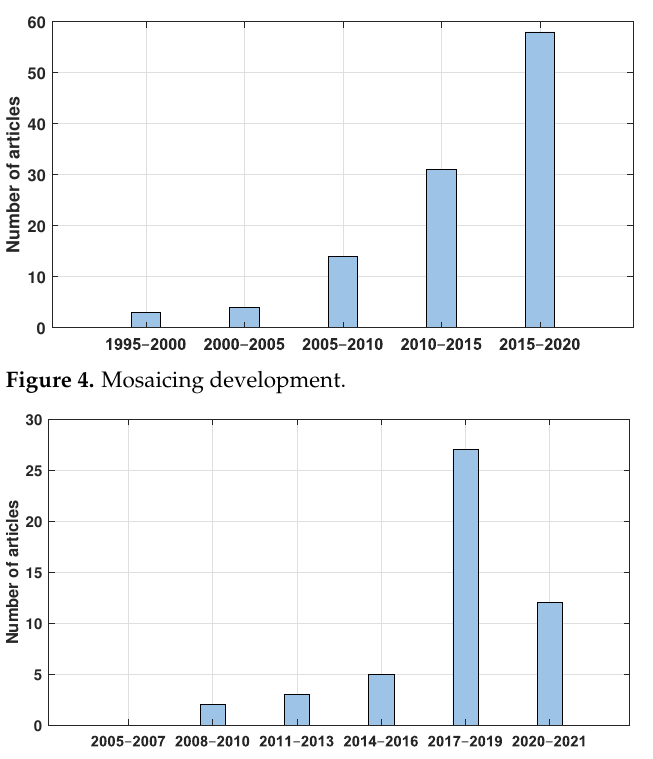
Figure 5. UAV mosaicing implementation.